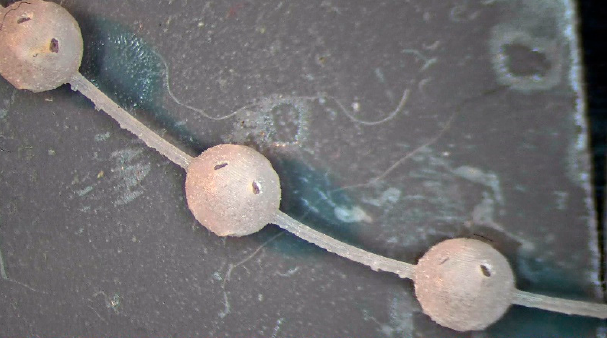
Figure 2. Vat photopolymerization: 3 mm beads built as a continuous chain arranged along a spiral on the build platform.